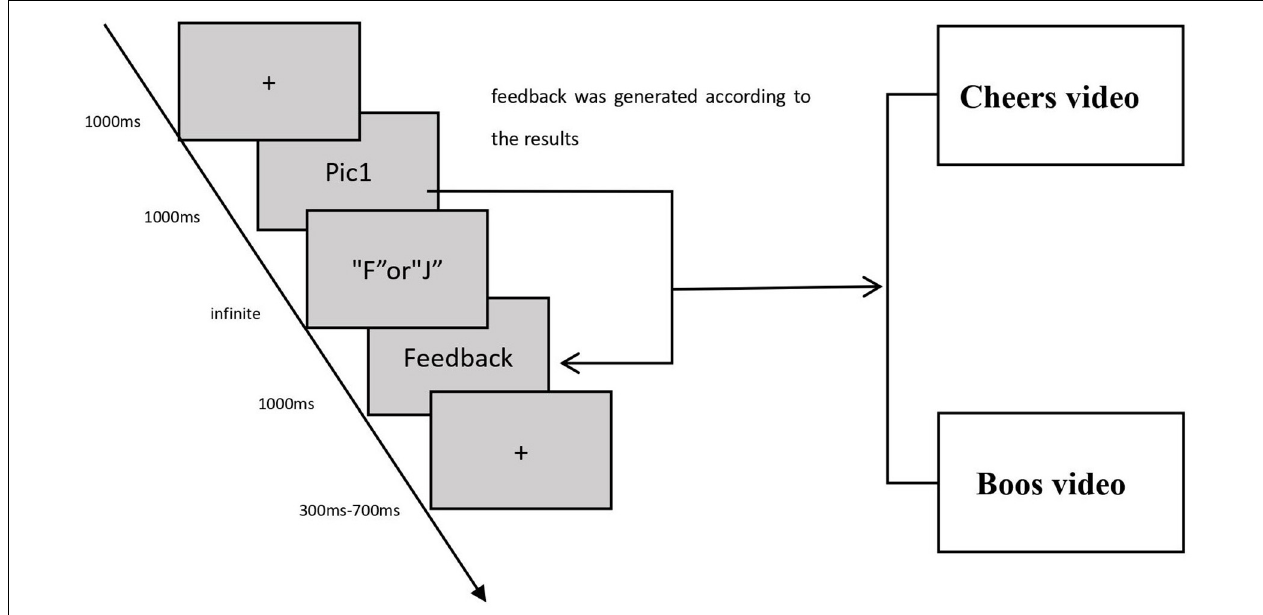
FIGURE 1 | Procedure for the judgment decision